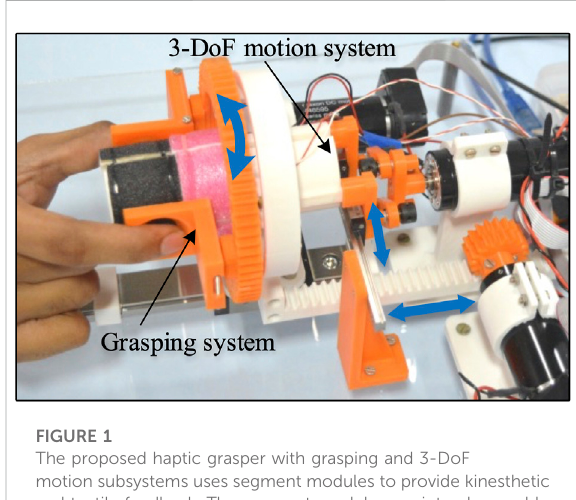
FIGURE 1 The proposed haptic grasper with grasping and 3-DoF motion subsystems uses segment modules to provide kinesthetic and tactile feedback. The segment modules are interchangeable and can be varied to render a variety of shapes, textures, edges, and active components corresponding to remote/virtual environments.